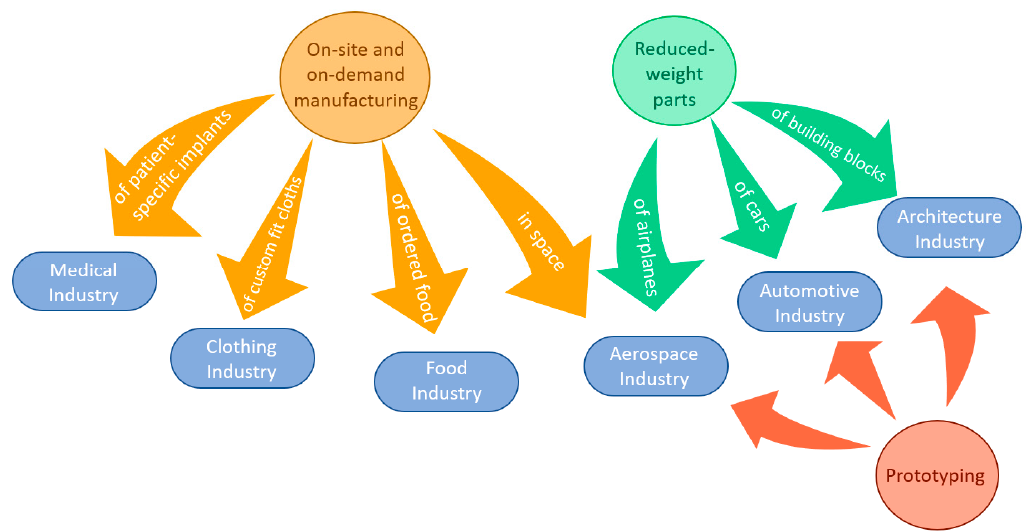
Figure 7. Application of AM features in different industries.